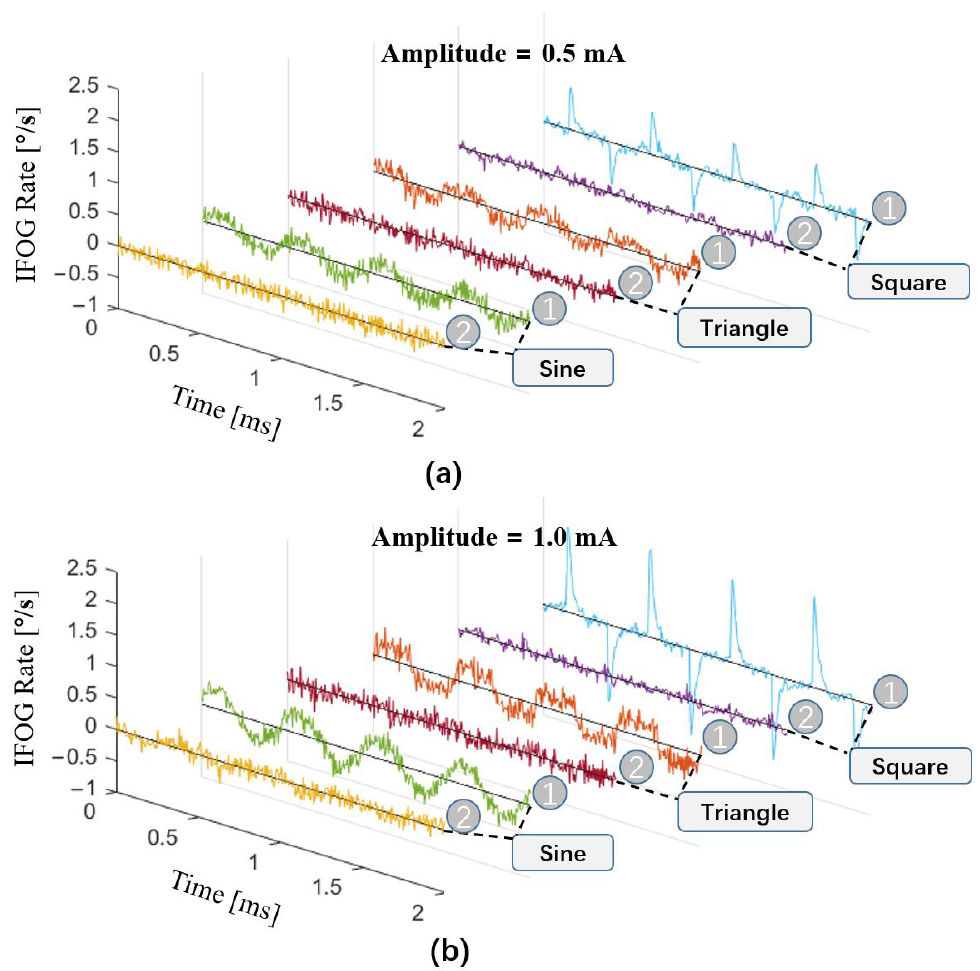
Figure 9. Experimental results with and without compensation for modulated driving currents with sine, triangle, and square waves. ( a ) Modulated current waves with an amplitude of 0.5 mA. ( b ) Modulated current waves with an amplitude of 1 mA.